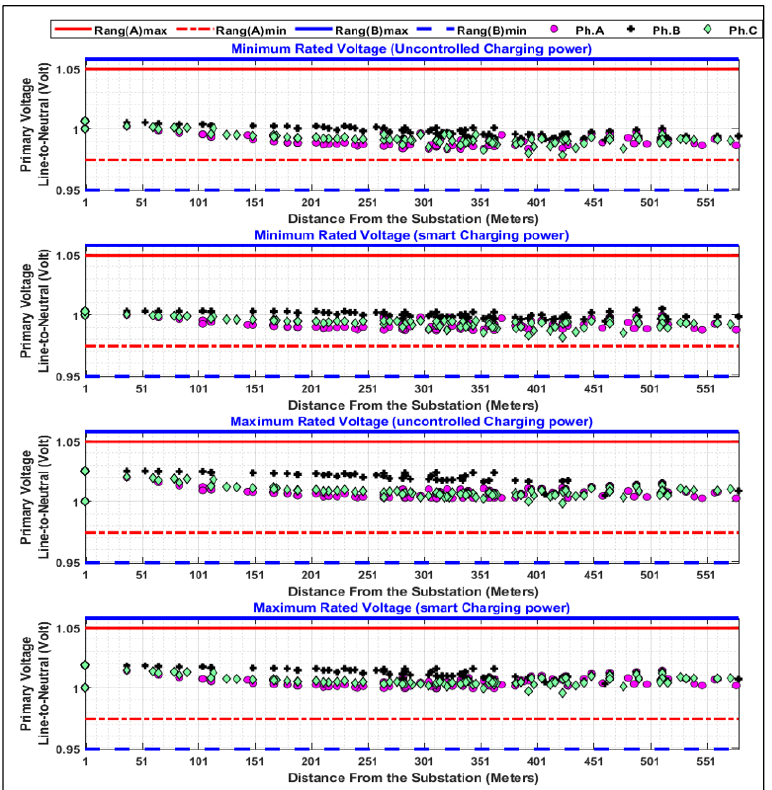
Figure 14. Minimum and maximum voltage experienced by each primary node when FCSs are con- nected.